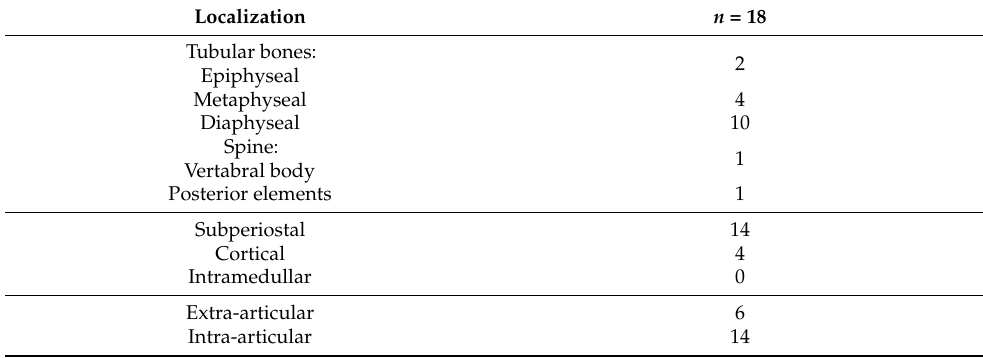
Table 1. Localization of osteoid osteoma.